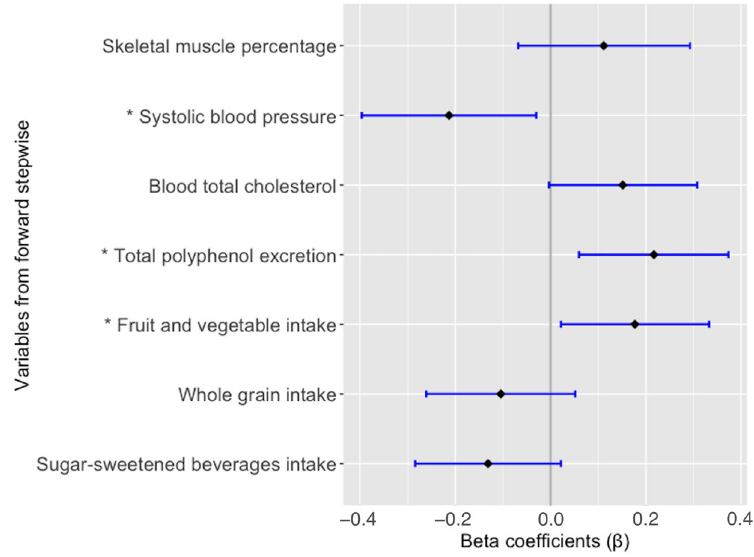
Figure 1. Multiple linear regression model for the association of nitric oxide. Adjusted by sex, age, smoking status, and BMI. All variables are expressed as z-score. * Statistically significant difference ( p -value < 0.05). Table 3. Association between nitric oxide with individual anthropometry, biochemical, physical activity, and dietary